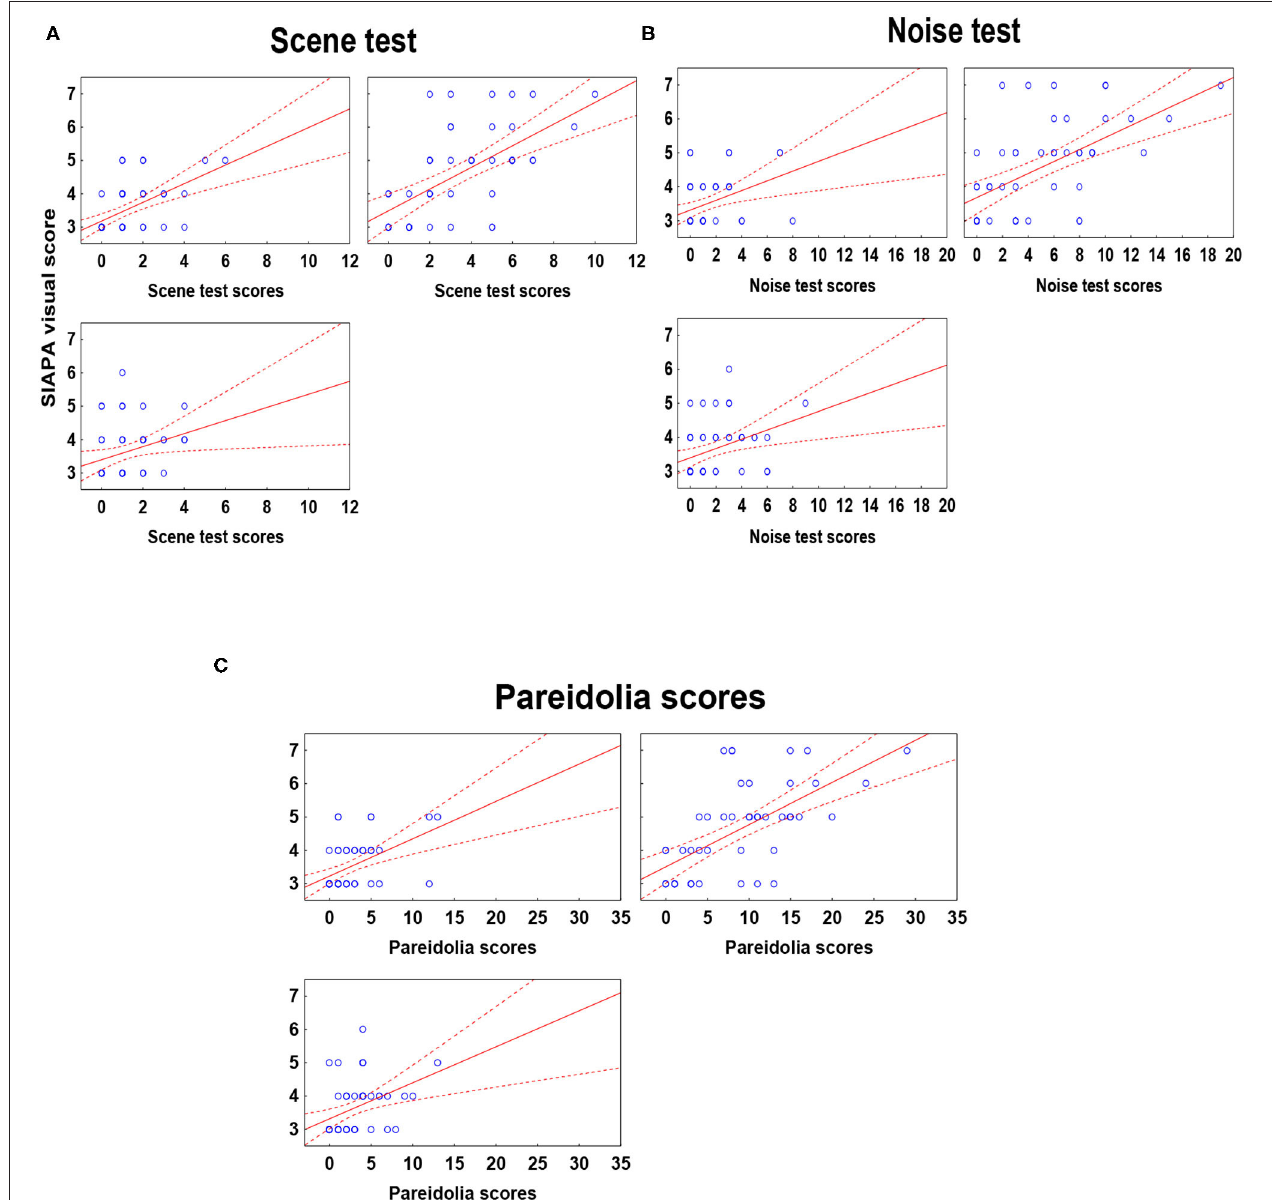
FIGURE 4 | Correlations between SIAPA (Structured Interview for Assessing Perceptual Anomalies) visual scores and (A) scence, (B) test, and (C) pareidolia test results. The correlation coefficients are shown in Supplementary Table 2 .